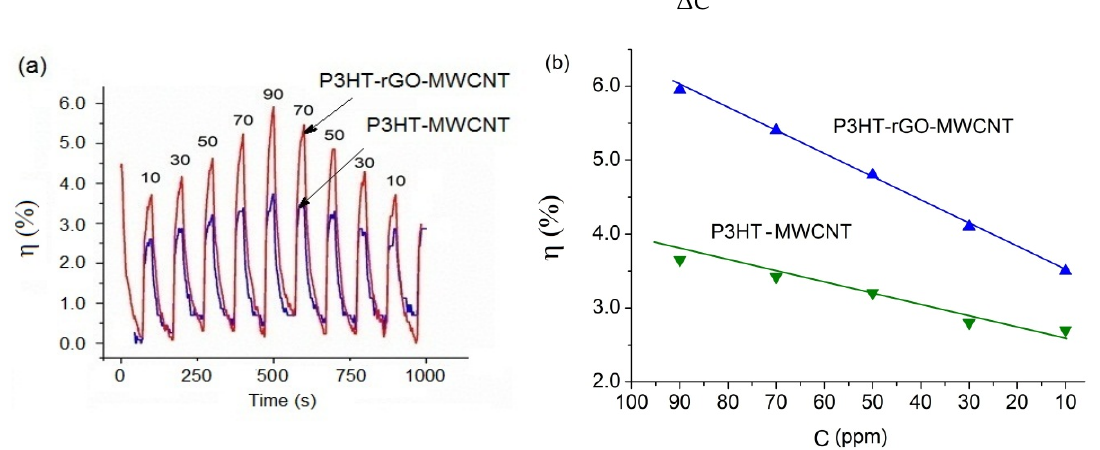
Figure 6. The ( a ) sensitivity and ( b ) relative sensitivity of P3HT-rGO-MWCNTs comparing to those of P3HT-MWCNTs sensors.